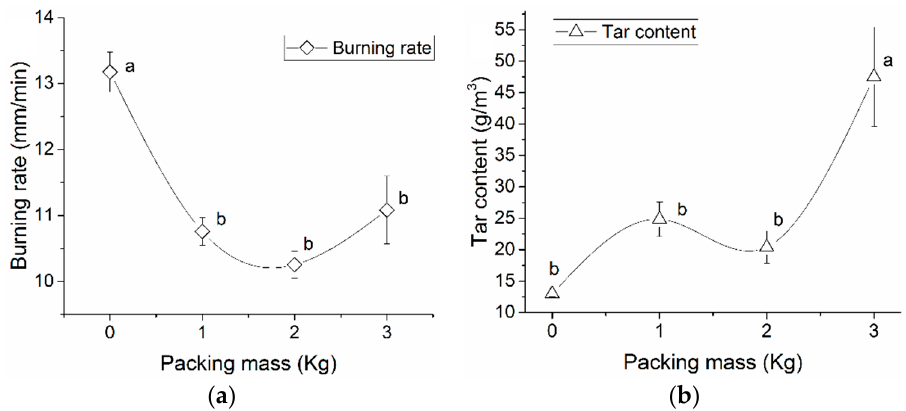
Figure 7. ( a ) Burning rate and ( b ) tar content in syngas using biomass at different biomass compactness. Airflow 20 lpm, 10% moisture content, avg. particle size 7 mm. Different letters on data points indicate significant differences ( p < 0.05).